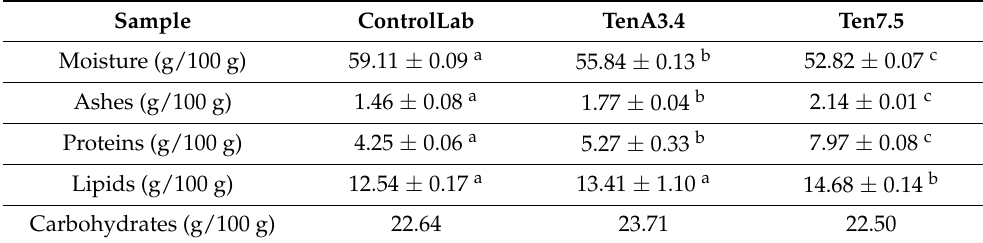
Table 3. Concentration in g/100 g of moisture, ash, protein, lipids, and carbohydrates of two sauces with different proportions of T. molitor flour (3.7% and 7.5%) and the commercial standard. Mean values with different letters (in the same row) indicate that they are significantly different (Tukey’s test, p <